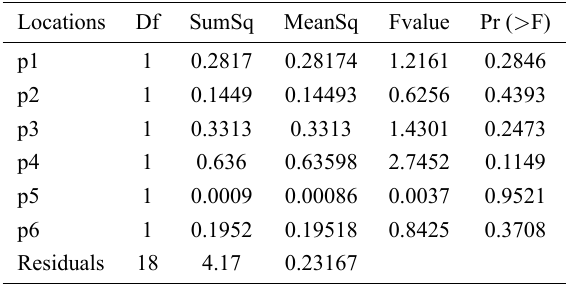
Table 3. ANOVA effect of wrestling training frequency on the location of weak links in low threshold